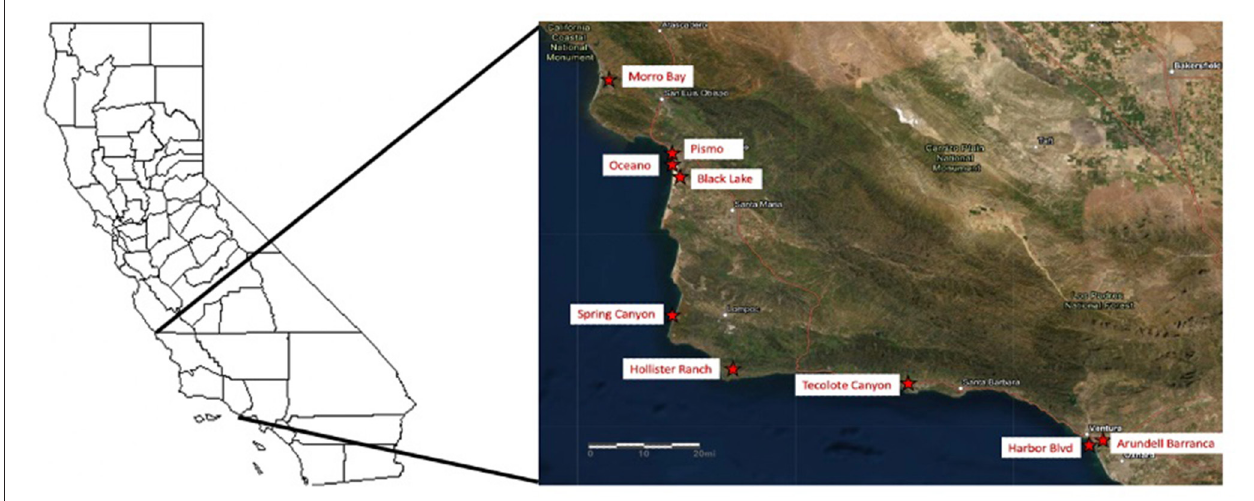
FIGURE 1 | Nine groves sampled along the California coast in Ventura, Santa Barbara, and San Luis Obispo counties that met study design criteria (see text). The groves from south to north are: Arundell Barranca (V), Harbor Blvd (V), Tecolote Canyon (SB), Hollister Ranch (SB), Spring Canyon Vandenberg Air Force Base (SB), Black Lake (SLO), Oceano Campground (SLO), Pismo Beach State Park (SLO), and Morro Bay Golf Course